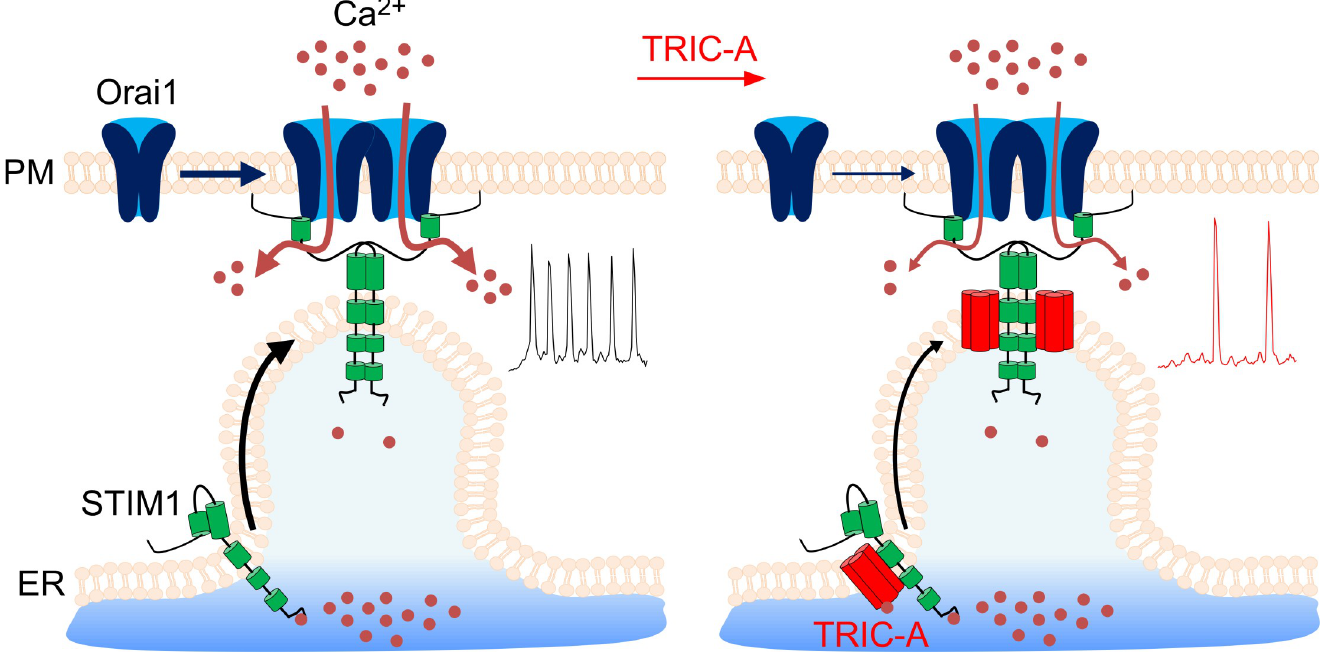
Fig 7. Schematic diagram illustrating the role of TRIC-A in limiting SOCE and oscillatory Ca 2+ signals by interfering with STIM1/Orai1 complex assembly. Left: Upon ER Ca 2+ depletion via RyR/IP 3 R, STIM1 loses bound Ca 2+ from its EF-hand, undergoes a conformational change, oligomerizes, and translocates into clusters at ER–PM junctions. STIM1 then recruits Orai1 channels into the clusters and activates the Ca 2+ -selective pore for subsequent Ca 2+ entry into the cells to sustain RyR/IP 3 R-triggered Ca 2+ oscillations. Right: TRIC-A translocates along with STIM1 to ER–PM junctions, where it interferes with STIM1/Orai1 coupling, which consequently limits the Ca 2+ influx via Orai1 (SOCE) and the frequency of cytosolic Ca 2+ oscillations. ER, endoplasmic reticulum; I CRAC , Ca 2+ release-activated Ca 2+ current; IP 3 R, inositol 1,4,5-triphosphate receptor; Orai1, Ca 2+ -release–activated Ca 2+ channel 1; PM, plasma membrane; RyR, ryanodine receptor; SOCE, store- operated Ca 2+ entry; STIM1, stromal interaction molecule 1; TRIC, trimeric intracellular cation.